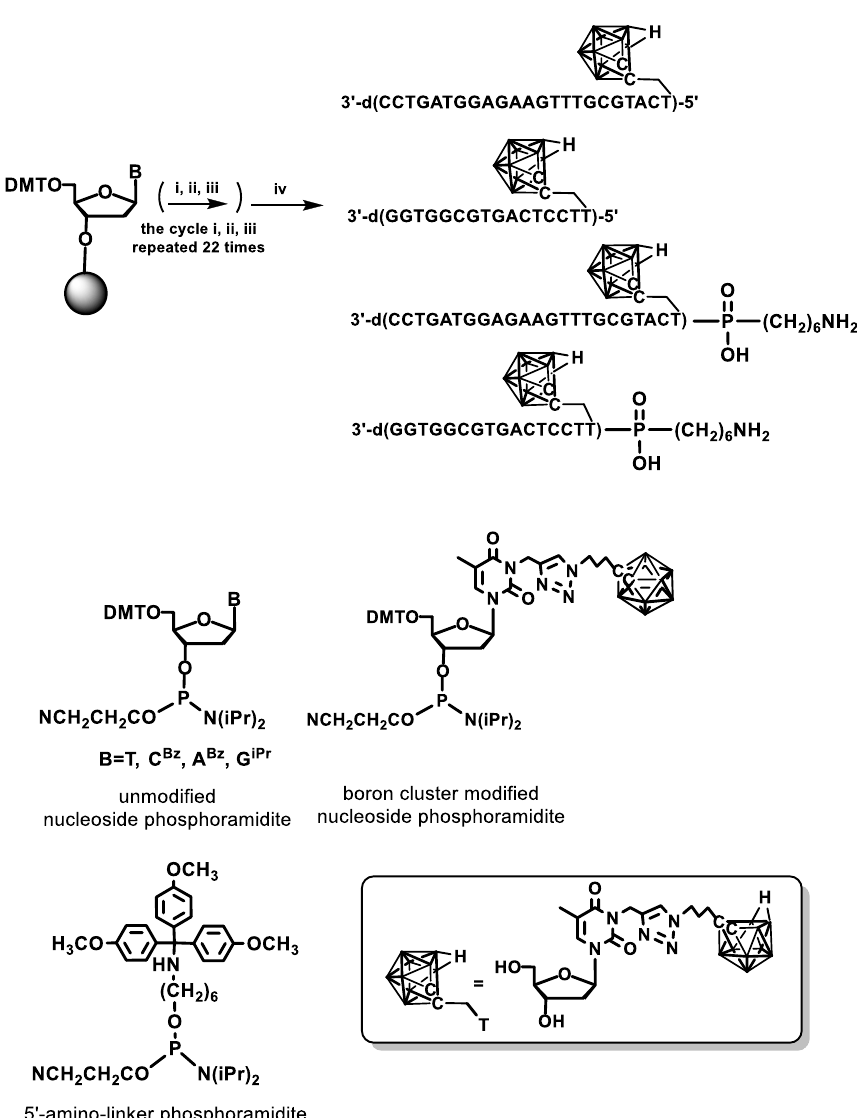
Scheme 4. Synthesis of oligonucleotides containing carborane cluster at the 5′-end of the oligonucleotide chain: (i) detritylation; (ii) coupling; (iii) oxidation and capping; (iv) cleavage